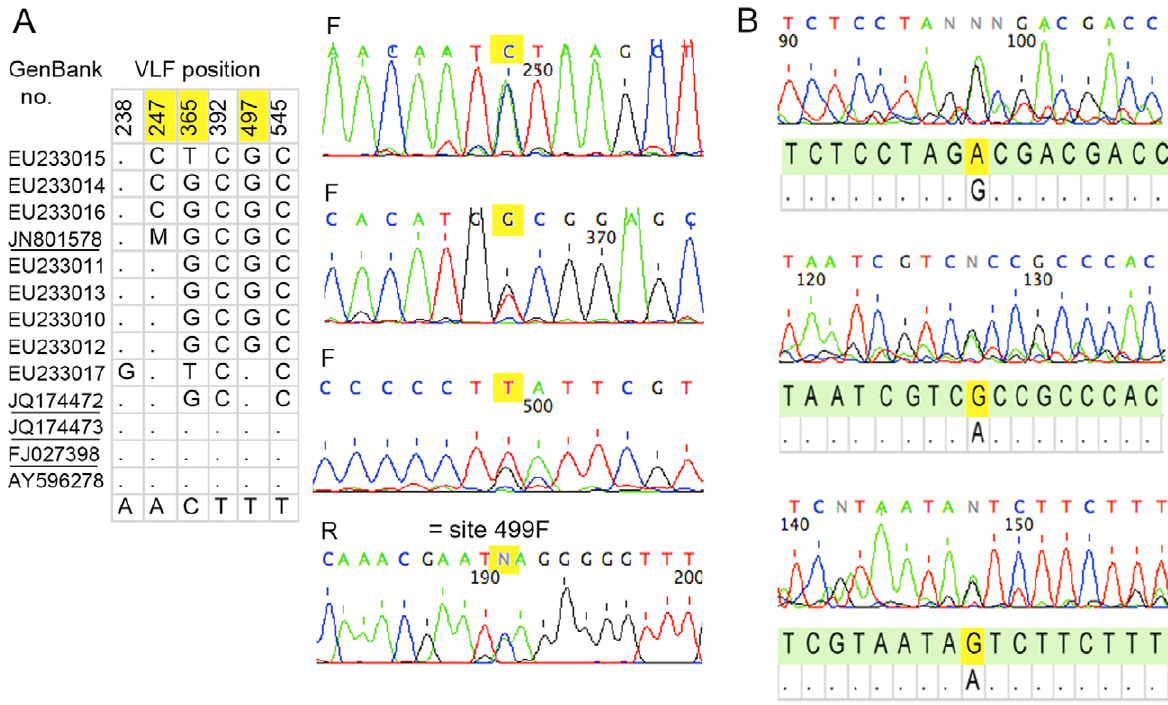
Figure 5. Additional BARCODEs with multiple shared amino acid VLFs reflect co-amplified pseudogenes. A) Cnemotriccus fuscatus . Nucleotides underlying amino acid VLFs for all C. fuscatus GenBank records are shown (underlined are BARCODEs); complete mitochondrial genome sequence AY596278 is at bottom. Representative trace files show double peaks at VLF positions highlighted in yellow (BARCODE numbering differs by 2 from forward trace files). B) B. canadensis . Trace files for outlier BARCODEs display double peaks at VLF sites. The GenBank fasta file sequence for these records is shown with the VLF nucleotide highlighted in yellow and the sequence from a representative conspecific BARCODE lacking VLFs below.